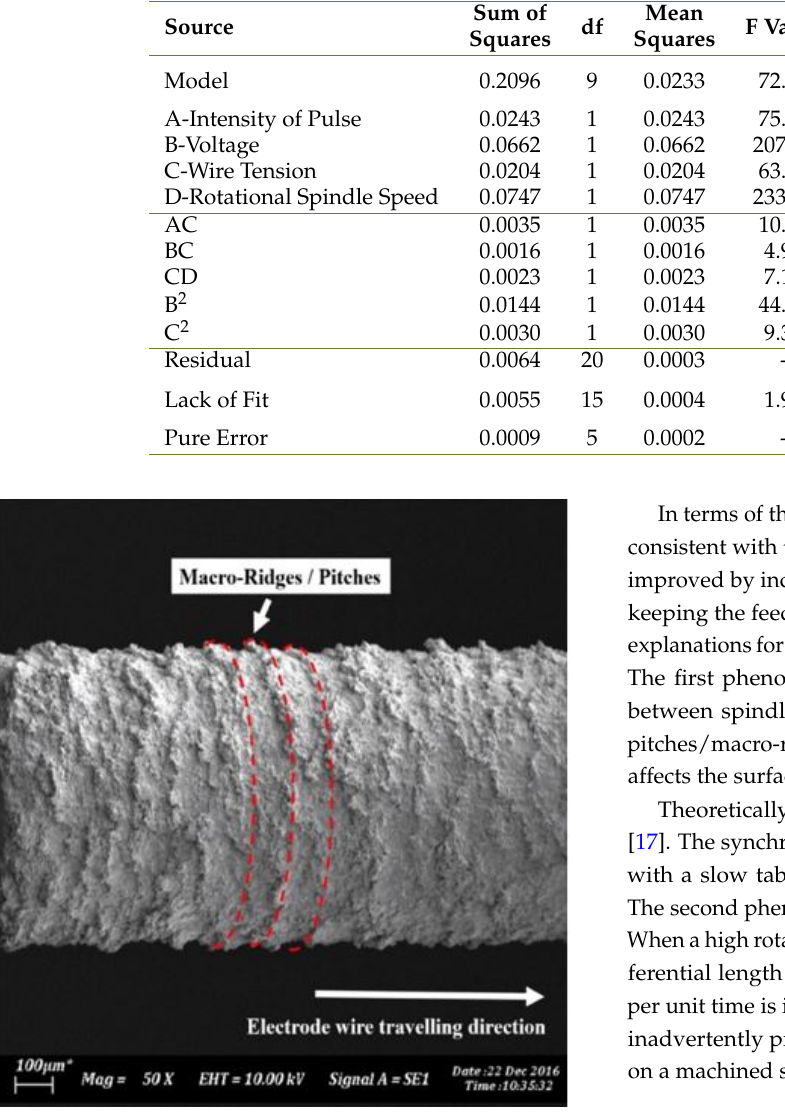
Fig. 5. The occurrence of macro-ridges in WEDT workpiece machined